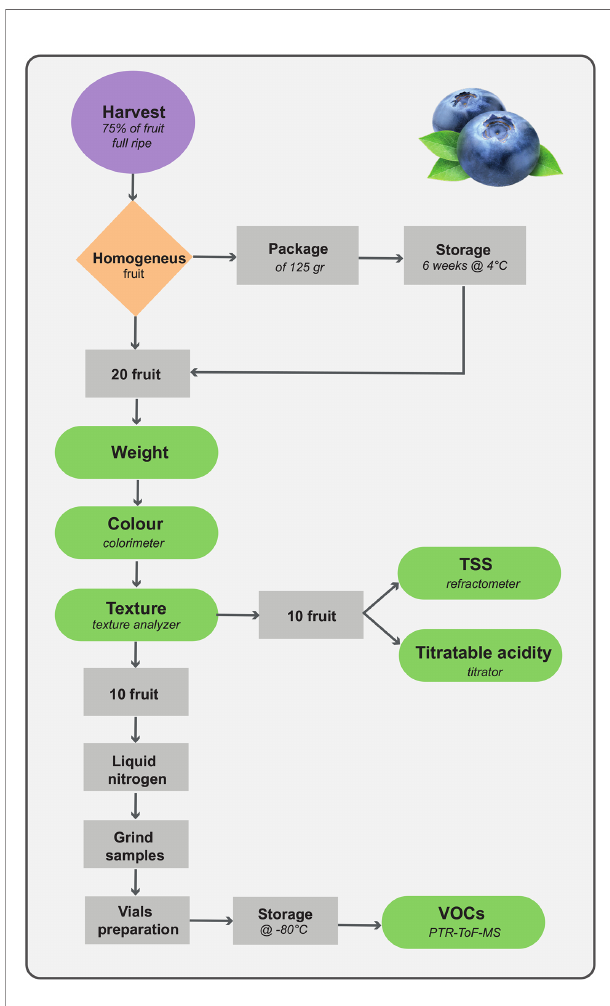
FIGURE 8 | Phenotyping assessment of quality traits applicable for blueberry breeding